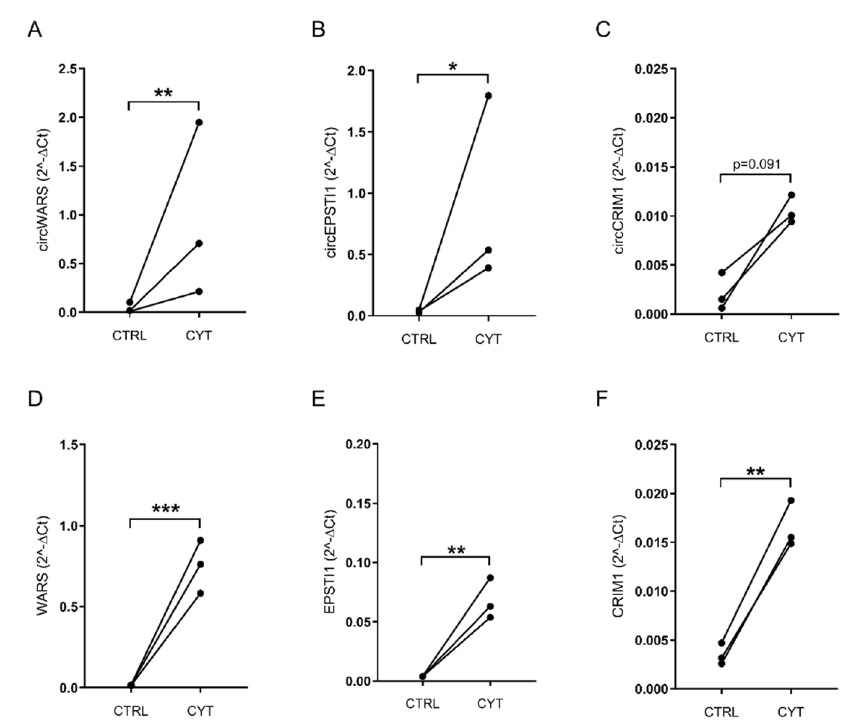
Figure 3. Validation of host genes and circRNAs of WARS , EPSTI1, and CRIM1 . The expression of ( A ) circWARS, ( B ) circEPSTI1, and ( C ) circCRIM1 and the mRNA expression of ( D ) WARS , ( E ) EPSTI1, and ( F ) CRIM1 in the EndoC- β H1 cells that were untreated (CTRL) or treated with IL-1 β and IFN- γ (CYT) for 48 h ( n = 3). The normalized expression values are presented as 2ˆ − ∆ Ct. GAPDH was used as housekeeping gene. * p < 0.05, ** p < 0.01, *** p <